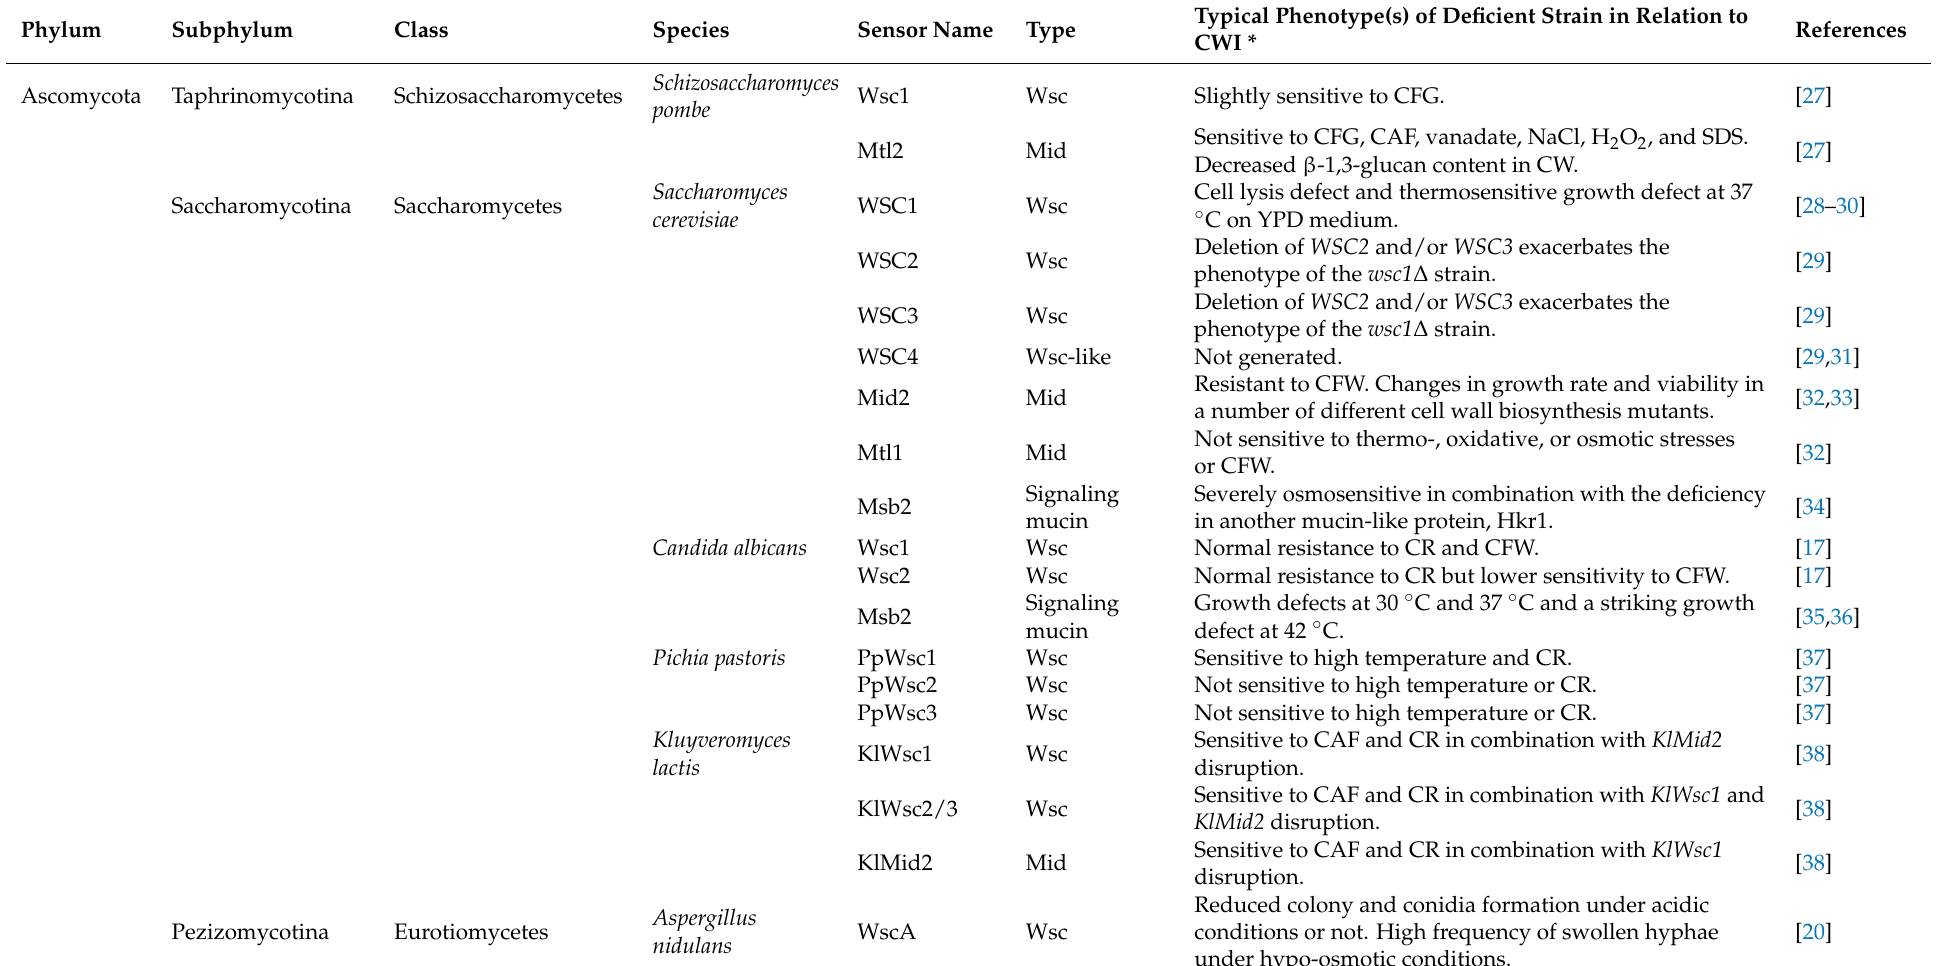
Table 1. Major fungal surface sensors whose functions have been